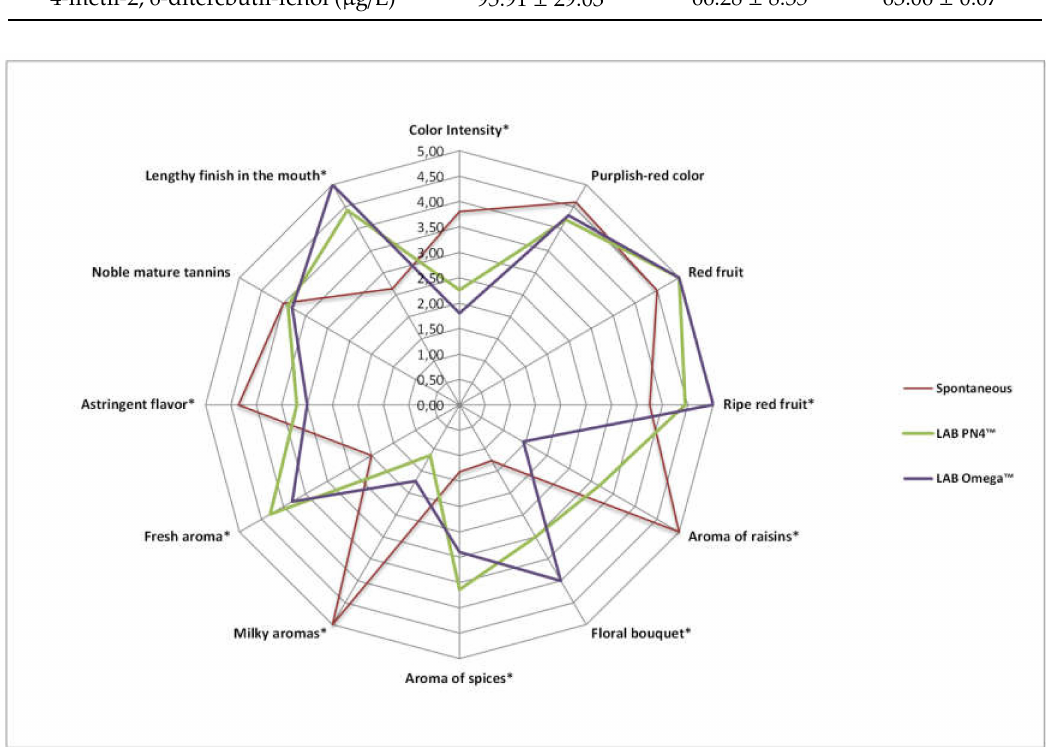
Figure 3. This figure shows the polar coordinate (cobweb) graph of mean sensory score ratings of “color intensity”, “purplish-red color”, “red fruit”, “ripe red fruit”, “aroma of raisins”, “floral bouquet”, “aroma of spices”, “milky aroma”, “fresh aroma”, “astringent flavor”, “noble mature tannins”, and “lengthy finish in the mouth” for the spontaneous Tempranillo wine and the PN4 ™ and Omega ™ LAB strains. In sensorial variables indicated with an asterisk (*) a di ff erence between trials was verified for p ≤